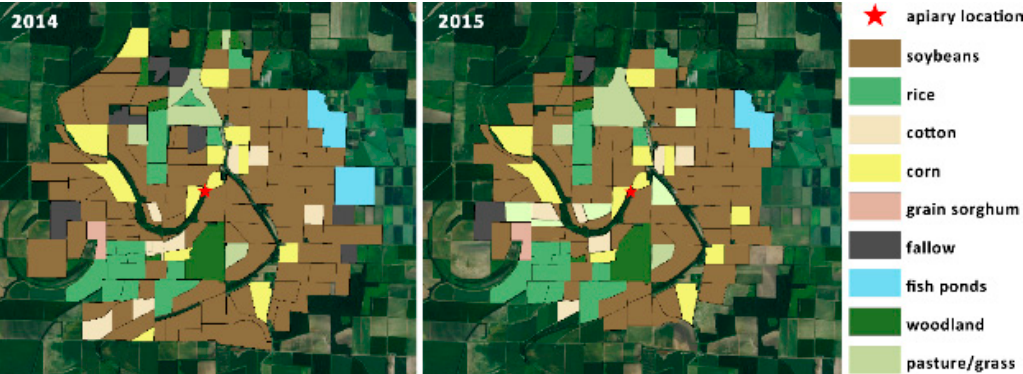
Figure 2. Land use by crop within the surveyed area around the High-Ag site during the 2014 and 2015 growing seasons. The survey area was slightly different between years due to changes in land use and an inability to contact farmers for interviews regarding all fields. However, general patterns of land use and crop production remained similar in the landscape around the apiary during both years.